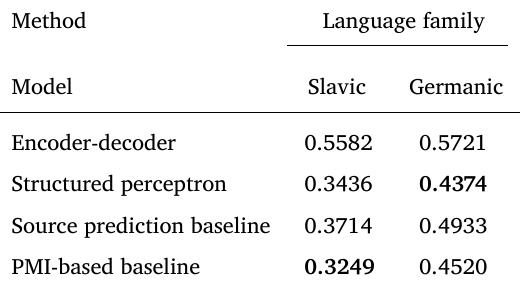
Evaluation of machine learning models and baseline models, with one-hot input data, evaluated on word prediction distance (edit distance between prediction and target) for different test conditions, for two language families: Slavic and Germanic. The distance is the mean of the distance of all language pairs in the family. Lower distance means better